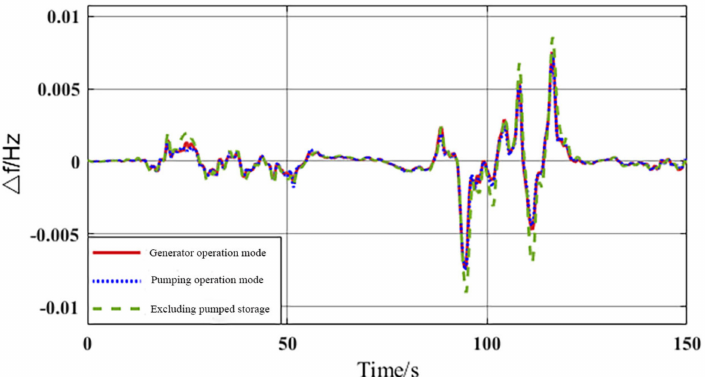
Figure 9. Frequency variation curve of a pumped storage unit under wind power